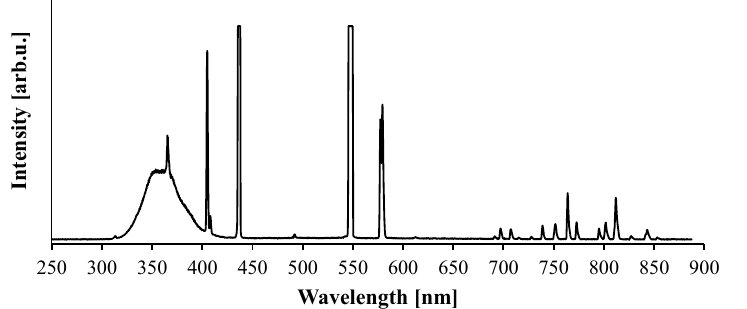
Figure 12. Emission spectrum of the UV-VIS lamp (6 × 20 W, Philips), 138 W/m 2 UV for 280–400 nm and 167 W/m 2 VIS for 300–2800 nm.